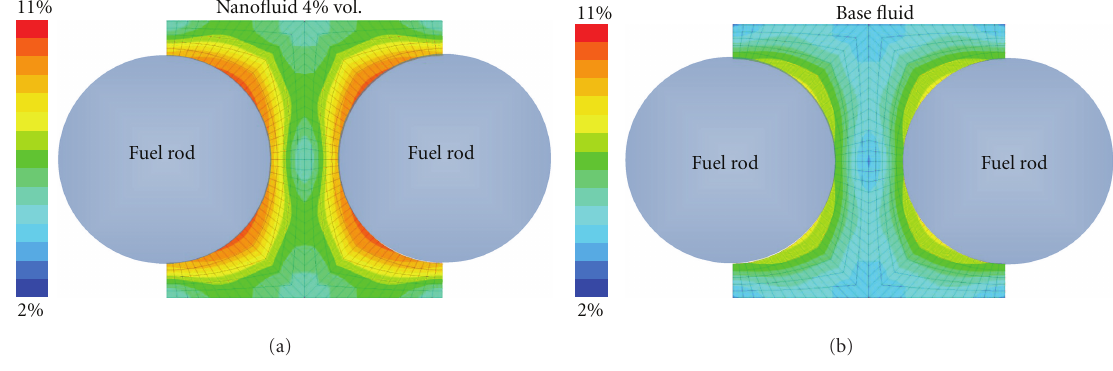
Figure 5: Turbulent intensity at the channel at Re = 80 × 10 3 .